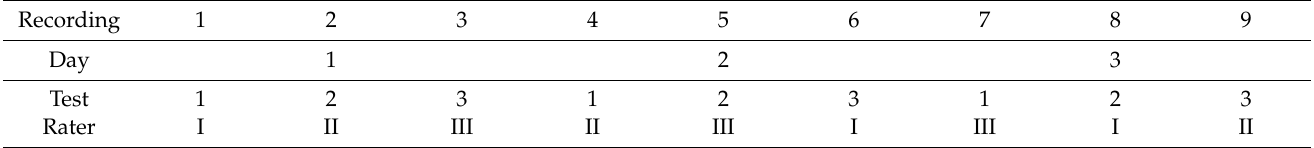
Table 1. Randomization of 3 raters during 3 days of data collection each day (9